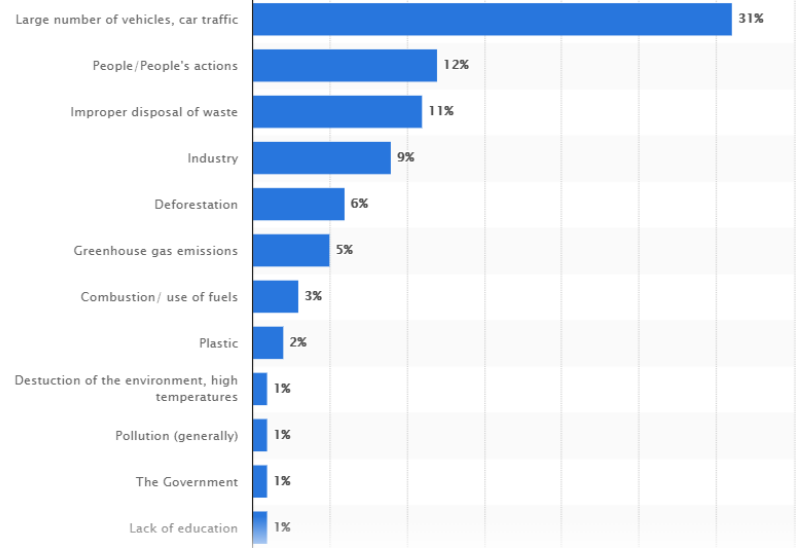
Figure A6. Main cause of global warming as perceived in Romania, 2019. Source: https://www.statista.com/statistics/1093956/perceived-causes-of-global-warming-romania/ (accessed on 8 June 2021).